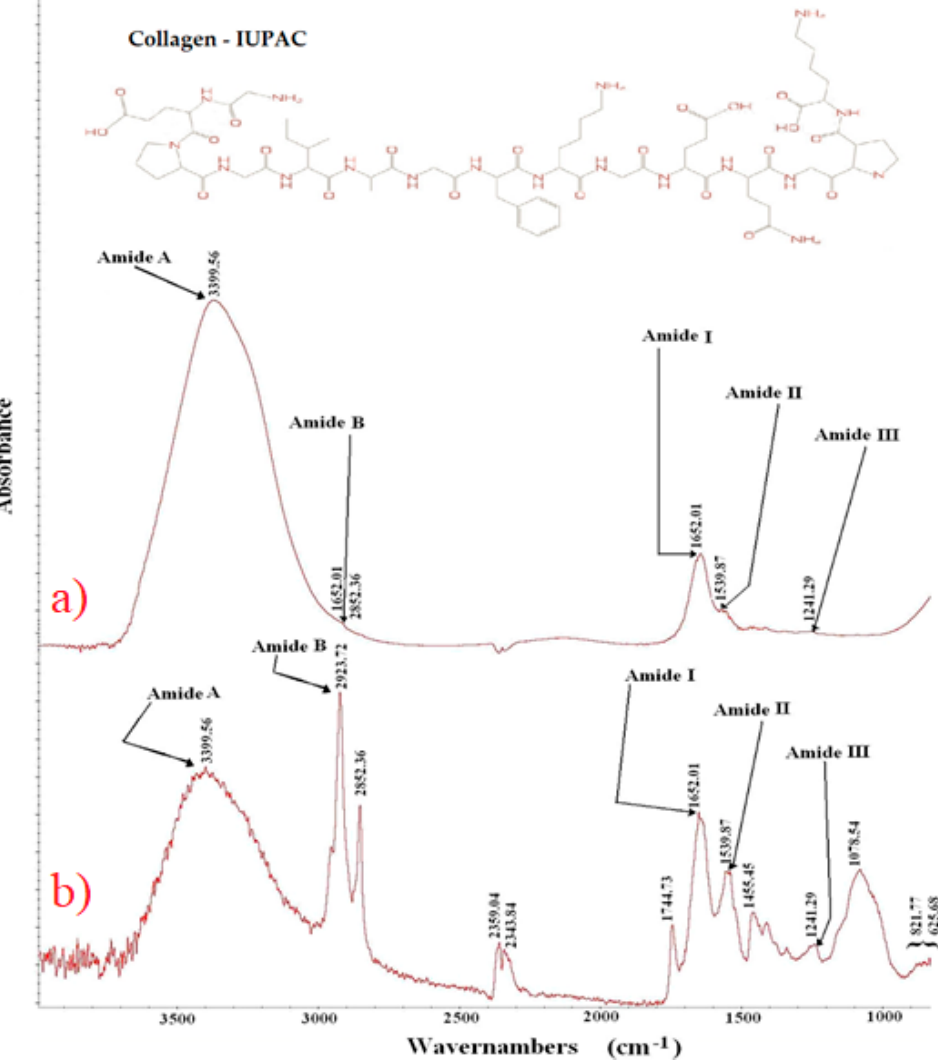
Figure 5. FTIR spectra of gelatins. ( a ) collagen from chicken feet, ( b ) collagen from commercial gelatin.